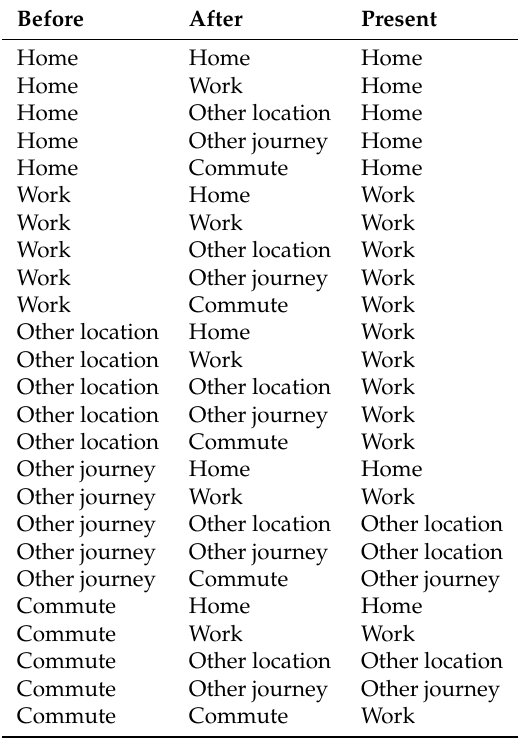
Table A2. Assignment of locations to activities with indefinite